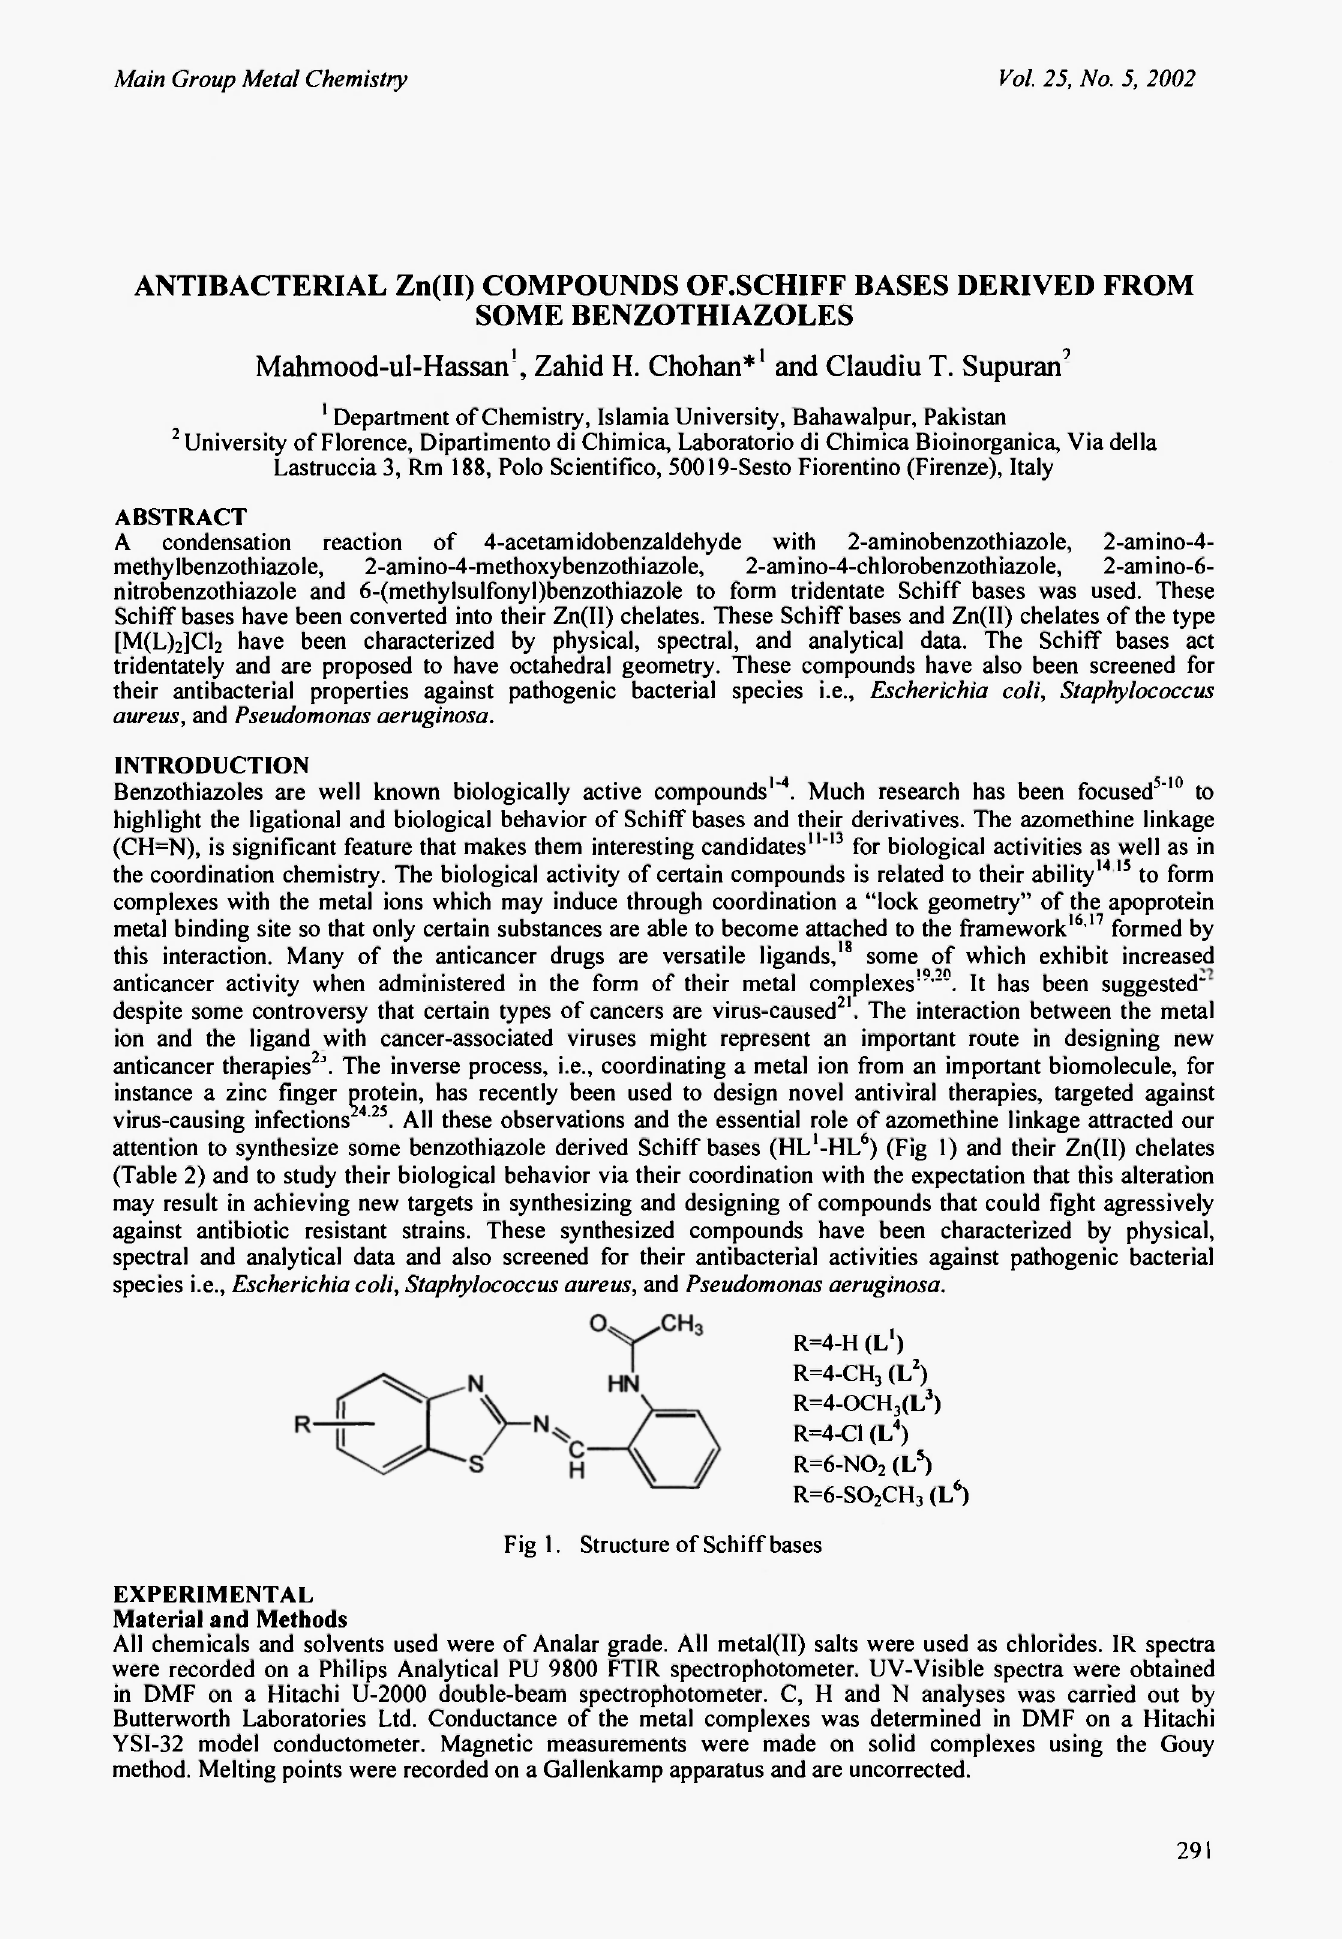
Fig 1. Structure of Schiff